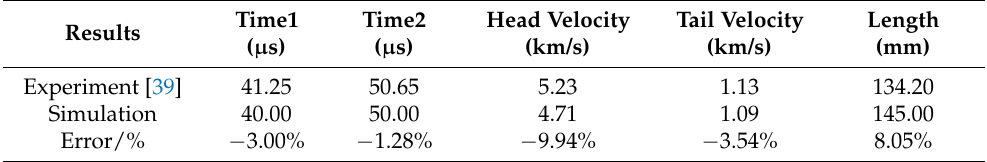
Table 4. Comparison of parameters between experimental [39] and simulated values.